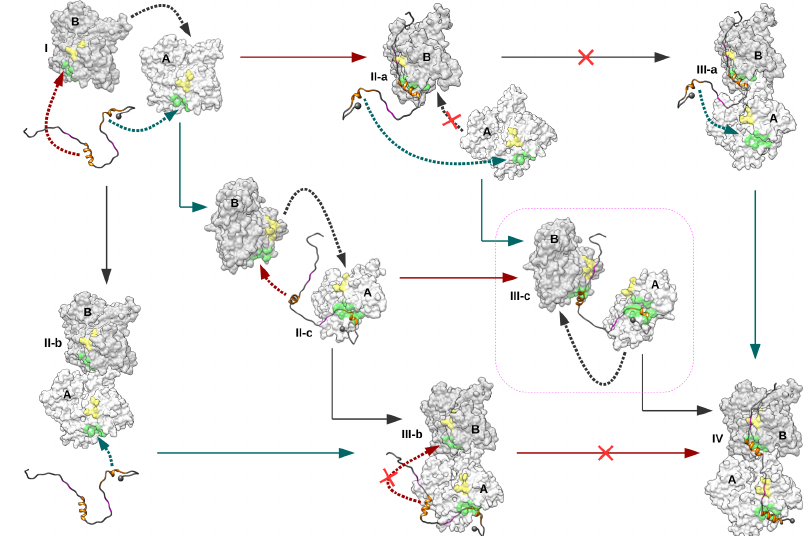
Figure 12. Possible pathways toward the formation of a 2:1 actin–domain V complex with a longitudinal actin dimer as observed in 3M3N. Starting from two actin chains and one N-WASP domain V (State I), three possible binary encounter complexes can be formed (States II-a, II-b, and II-c), leading to three possible intermediate ternary complexes (States III-a, III-b, and III-c) just before the final structure (State IV). Cyan and red arrows indicate the binding of the N-WASP first and second WH2 motif to actin chain A and B, respectively. Dark grey arrows represent the binding of two actins into a longitudinal